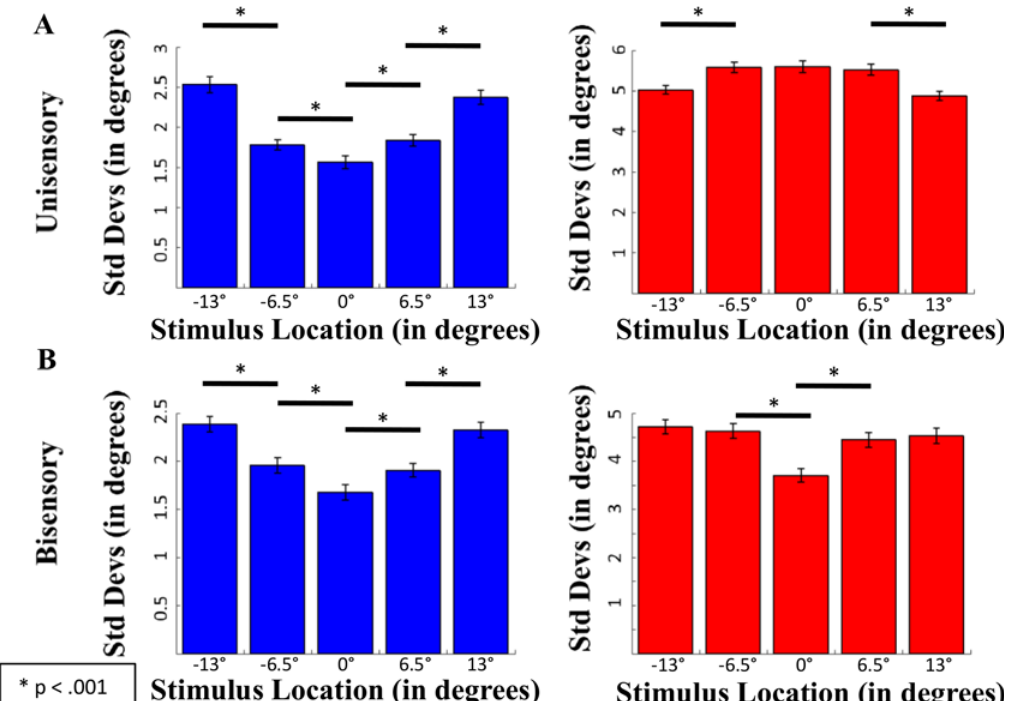
Fig 6. Standard deviations for all five stimulus positions. (A) Unisensory visual (blue) and unisensory auditory (red) localizations, and (B) bisensory visual (blue) and bisensory auditory (red) localizations are shown for each modality.